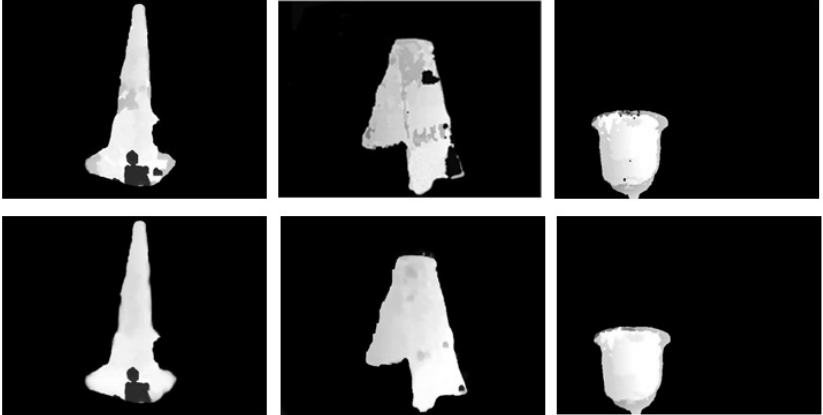
Figure 9. Optimization results of the disparity maps, where the basic disparity maps and the optimization results of the least squares plane fitting interpolation method are given in the first row and second row, respectively. Table 5. The fitting parameters of the disparity plane templates. Plane